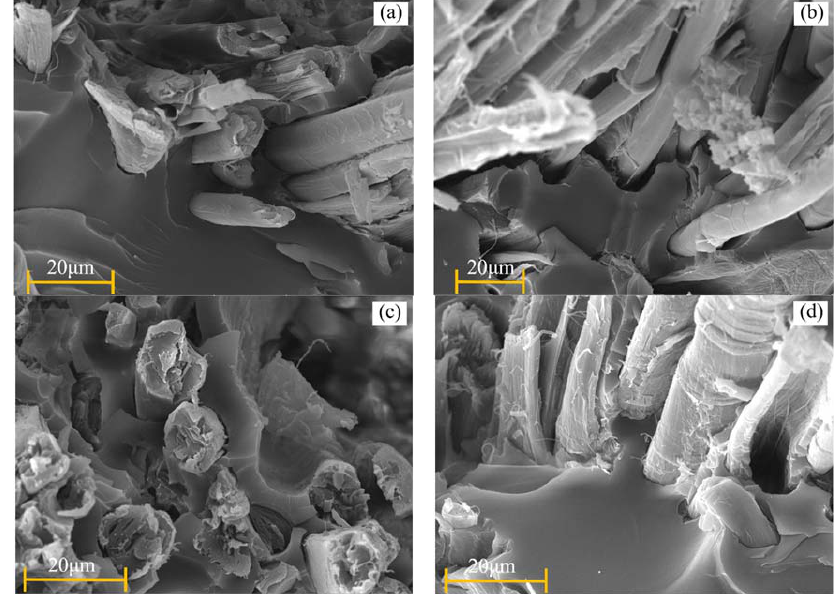
Figure 13. SEM photos of nano ‐ clay grafted FFRPs tensile fracture: ( a ) untreated FFRP before aging; ( b ) untreated FFRP immersion in 70 ◦ C under 80% RH for six weeks; ( c ) nano-clay grafted FFRP ( b ) untreated FFRP immersion in 70 °C under 80% RH for six weeks; ( c ) nano ‐ clay grafted FFRP before aging ( d ) nano ‐ clay grafted FFRP immersion in 70 °C under 80% RH for six weeks.